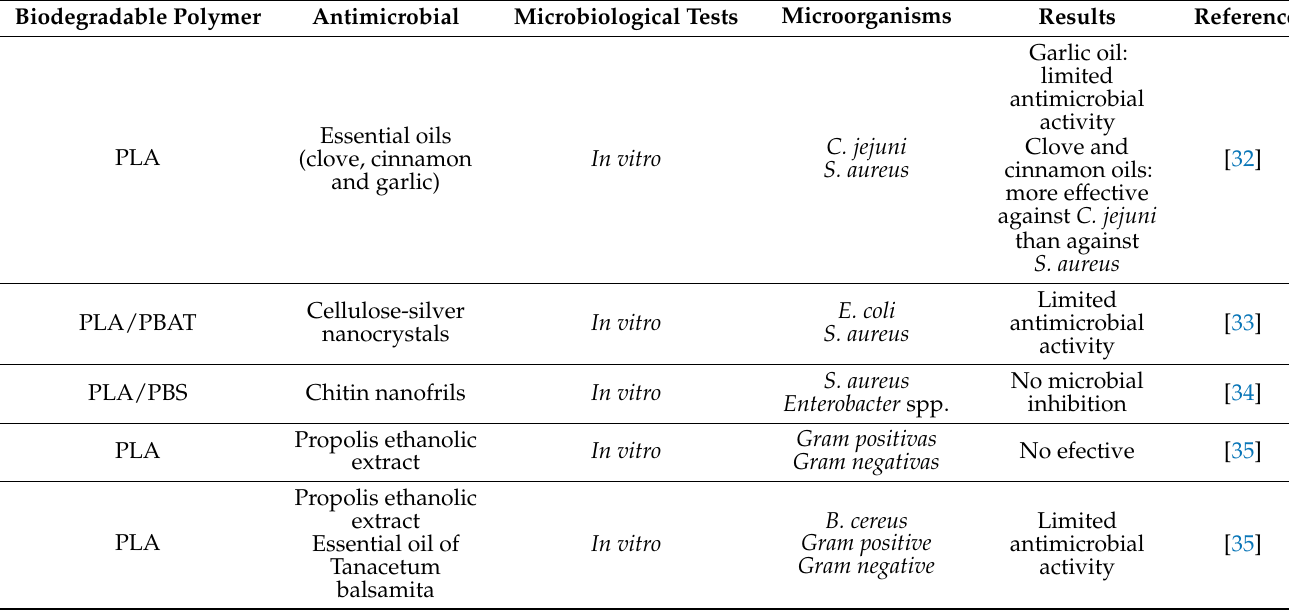
Table 2. Different studies on antimicrobial films based on synthetic biodegradable polymers (PLA, PVA and PCL). Biodegradable